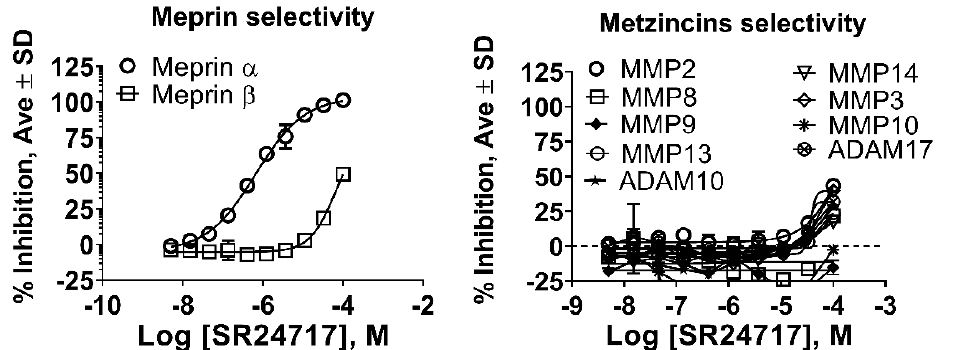
Figure 4. Characterization of a potential meprin α probe SR24717 against meprin β and related metzincins. ( A ) Dose response study of re-synthesis batch of SR24717 with meprin α and β ; ( B ) Dose response study of re-synthesis batch of SR24717 with metzincins shows good selectivity profile. All experiments performed as 10 point 3-fold concentration-response curves in triplicate. All units are IC 50 , µ M.